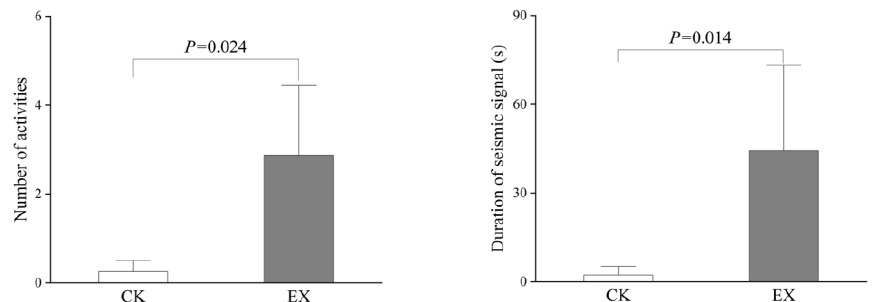
Figure 3. Comparison of the number of activities and duration of seismic signals within 48 h for plateau zokors in their control (CK) and experimental situations (EX). The bars in the figure are mean ± SE.